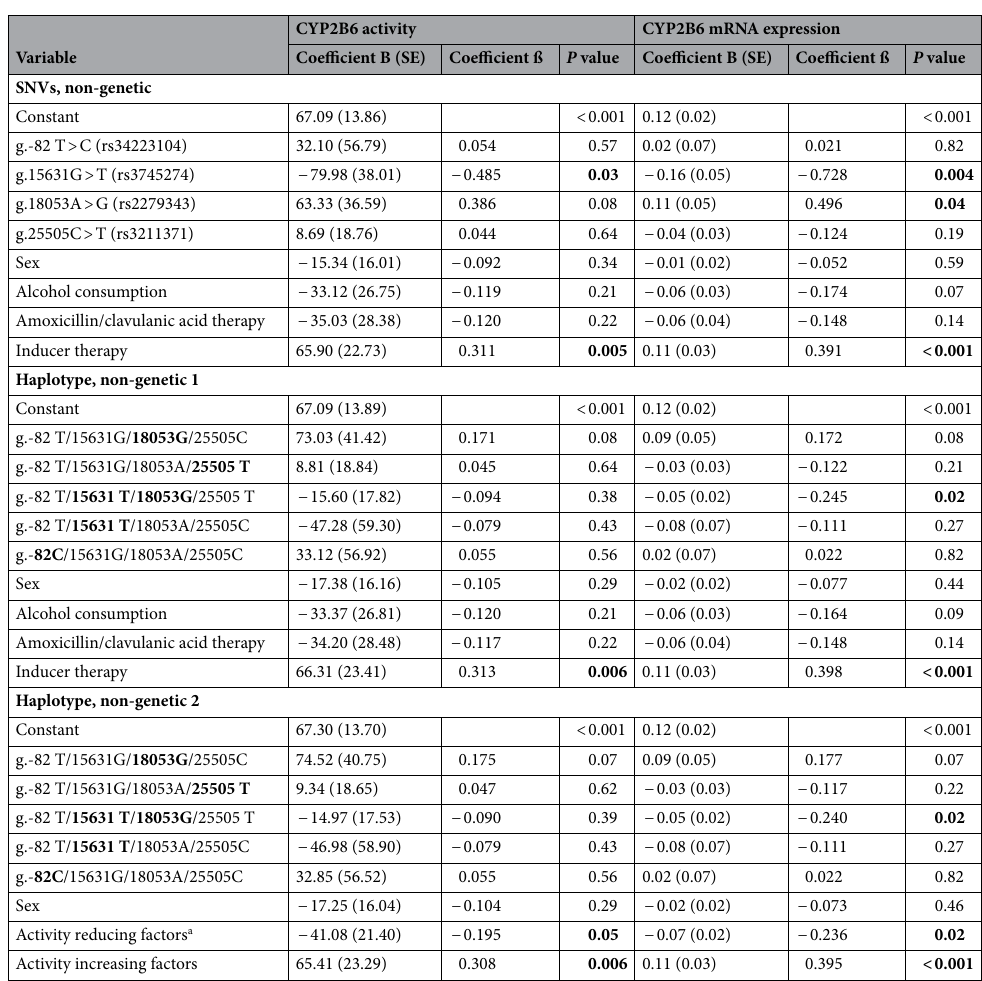
Table 4. Multivariate analysis on CYP2B6 activity ( S -mephenytoin N -demethylation) considering genetic ( CYP2B6 SNVs or haplotypes) and non-genetic factors. a Non-genetic factors: chronic alcohol consumption, amoxicillin + clavulanic acid therapy. In haplotypes, the polymorphic variants are indicated in bold. The P values < 0.05 were considered to be statistically significant and are indicated in